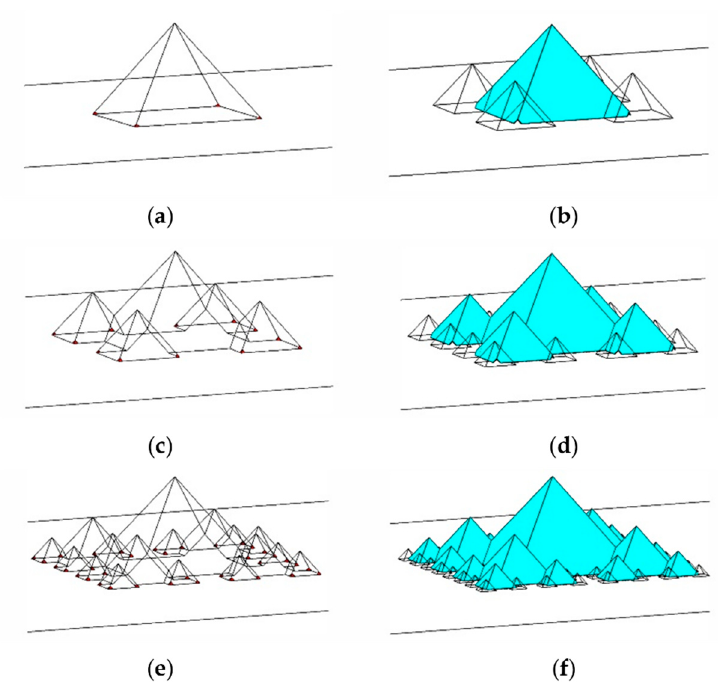
Figure 3. Schematic overview of the formation of fractals in lateral direction using corner lithogra- phy ( a , c , e ) in combination with anisotropic wet-chemical of silicon ( b , d , f ).